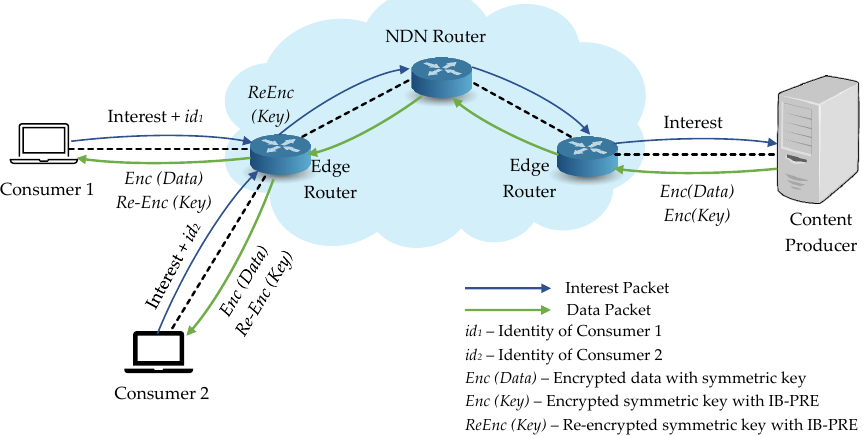
Figure 4. Overview of system architecture for our proposed